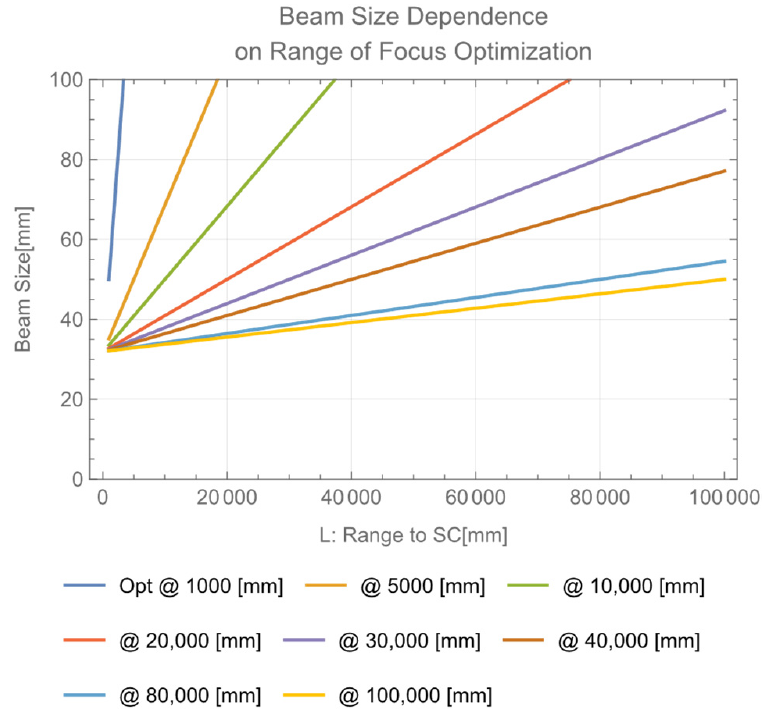
Figure 3. Beam size with focus adjustment at fixed range.